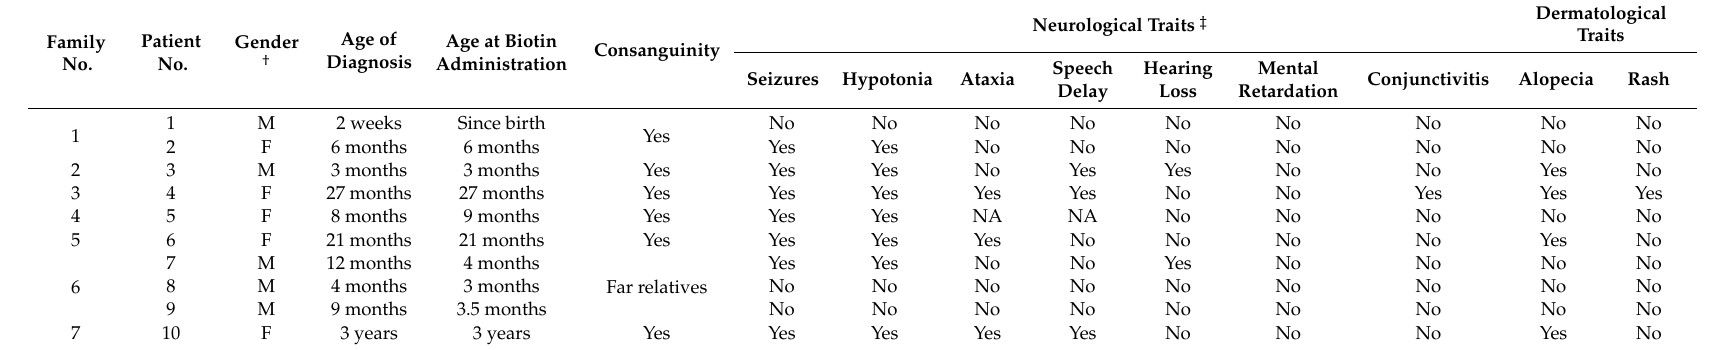
Table 2. Clinical characteristics of 10 biotinidase gene ( BTD )-deficient patients in Jordan. Family